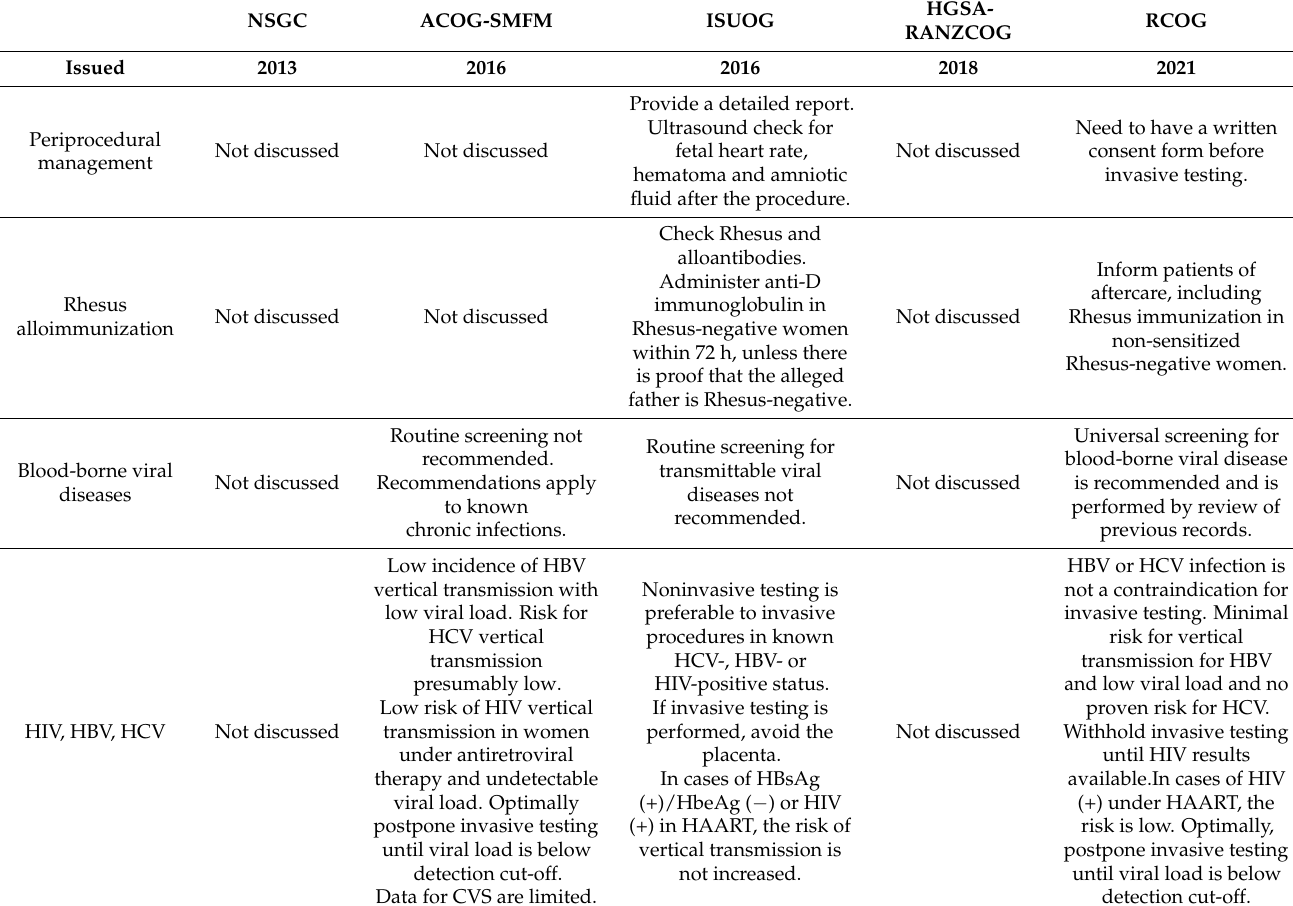
Table 4. Summary of recommendations on periprocedural management at invasive prenatal diagnos- tic